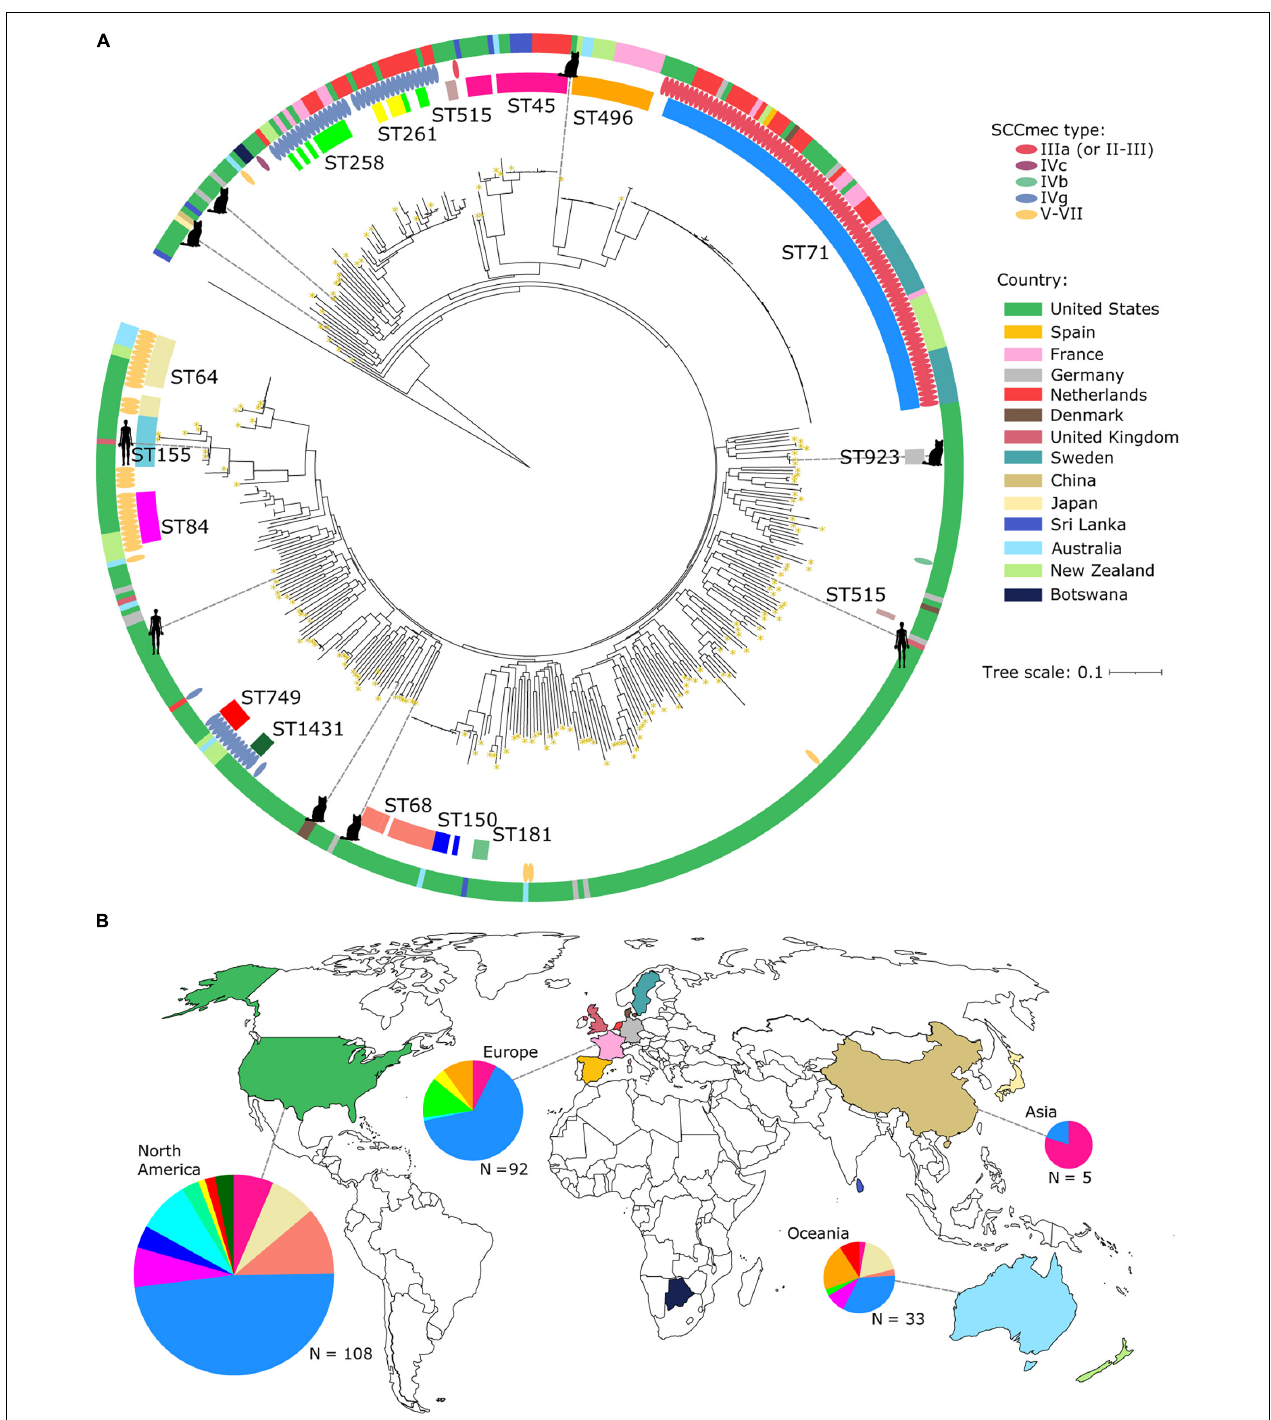
FIGURE 2 | Core genome phylogenetic tree of the global S. pseudintermedius population. (A) Midpoint-rooted maximum likelihood tree showing the phylogenetic relationships of 468 S. pseudintermedius genomes. The tree was built using sequence variation in 1,634 core genes. Scale bar represents the number of nucleotide substitutions per site. Also shown are the STs, SCC mec types and country of origin. For visual clarity, only STs of MRSP from large phylogenetic clusters were labeled. Images of hosts were only shown for those isolates sampled from cats and humans, while the rest came from dogs. Yellow asterisks on branch tips represent genomes from New England. (B) Geographical distribution of STs. Colors of countries on the map correspond to the same colors in panel a. Colors in the pie charts correspond to the STs in panel a. Only proportions of the major STs that have SCC mec are shown in the pie charts. The size of the pie charts is proportional to the number of